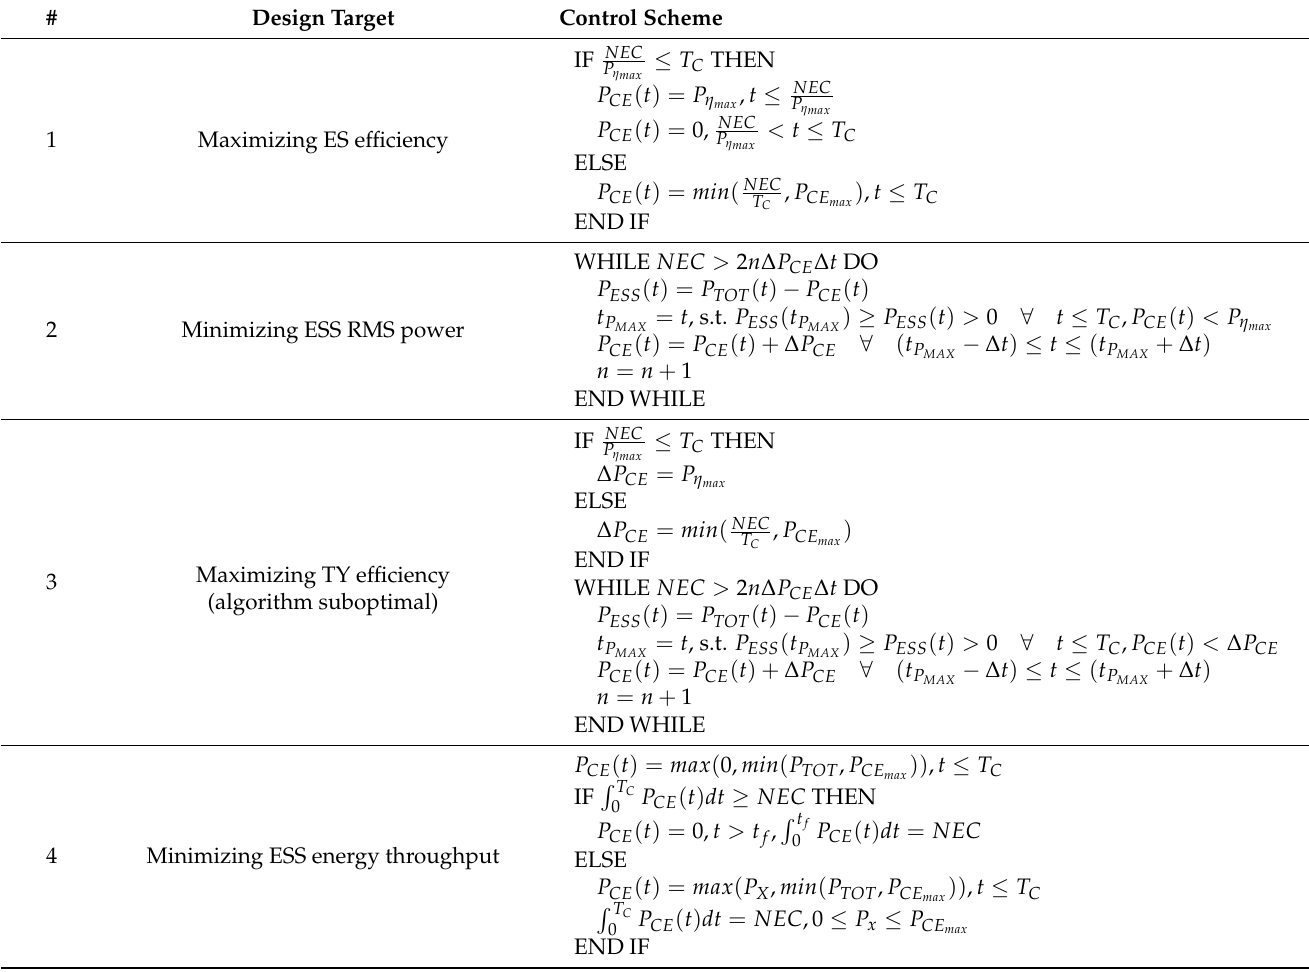
Table 8. Key ES control design considerations and proposed corresponding control